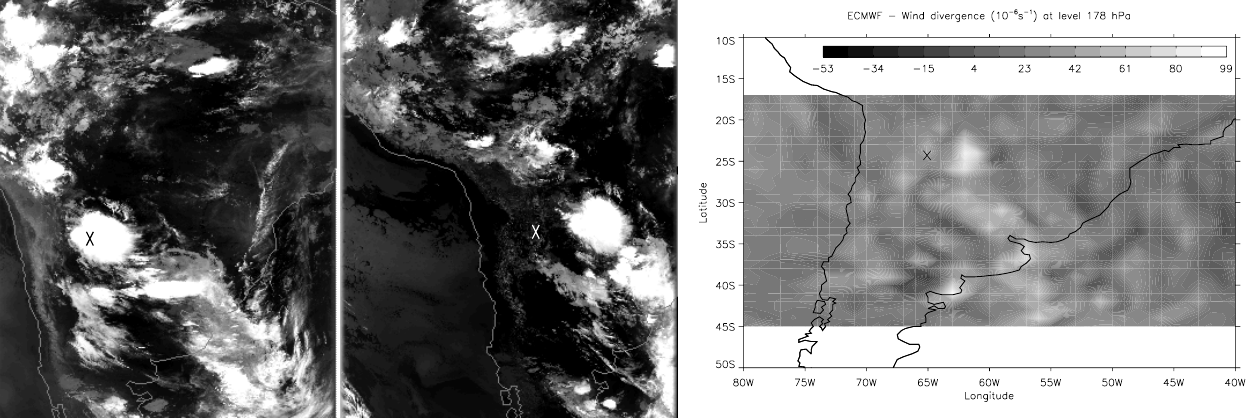
Fig. 11. Case 2: Left: Satellite images. DMSP IR satellite images at 09:55UTC and 12:19UTC. Right: ECMWF reanalysis. Wind convergence/divergence field (s − 1 ) at 12:00UTC at the 178hPa level (altitude ∼ 10.5km). Salta location is indicated by a cross.